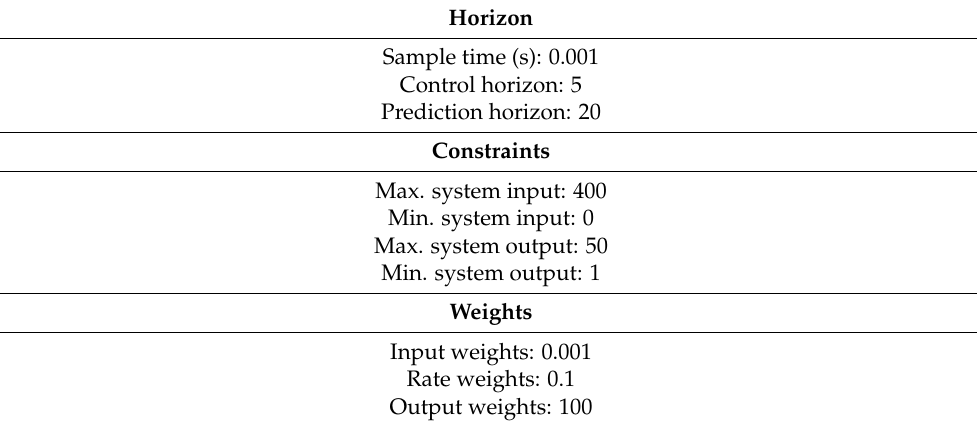
Table 4. Design parameters for MPC controller.